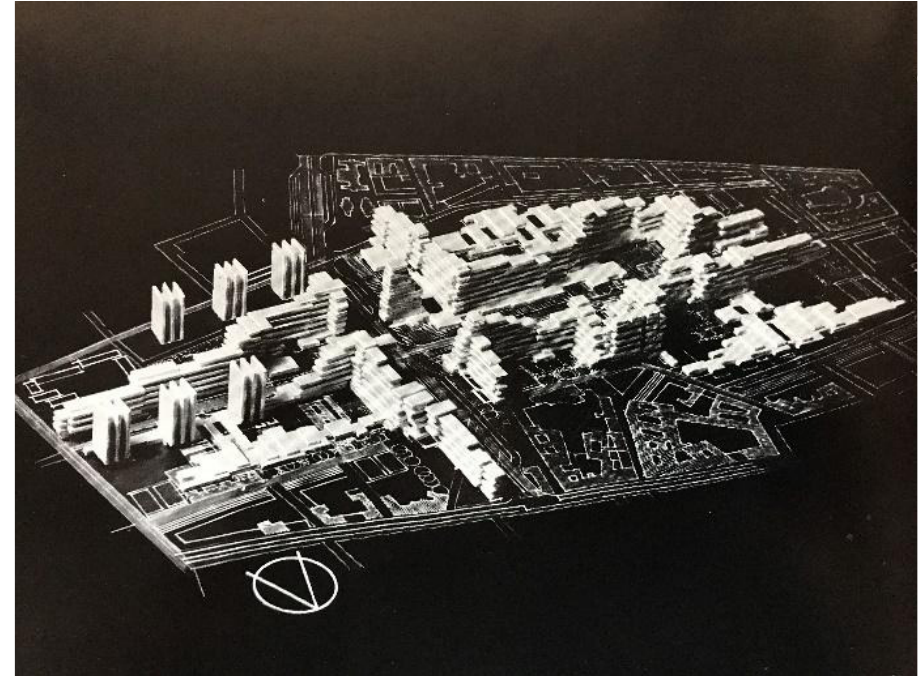
Figure 3. One of the proposals for the urban regeneration of Middle‐Józsefváros in the 1960s. Source: Preisich (1973, p. 42). Urban Planning, 2021, Volume 6, Issue 4, Pages